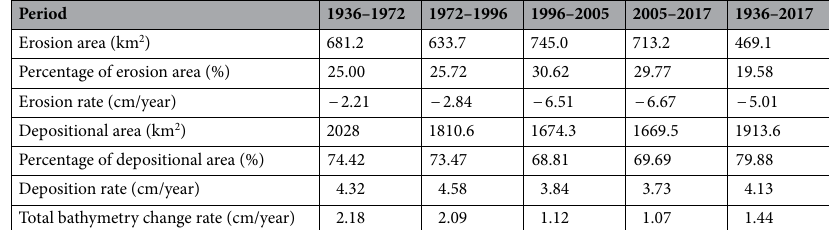
Table 3. Changes in erosion and depositional areas in the estuary in different periods.